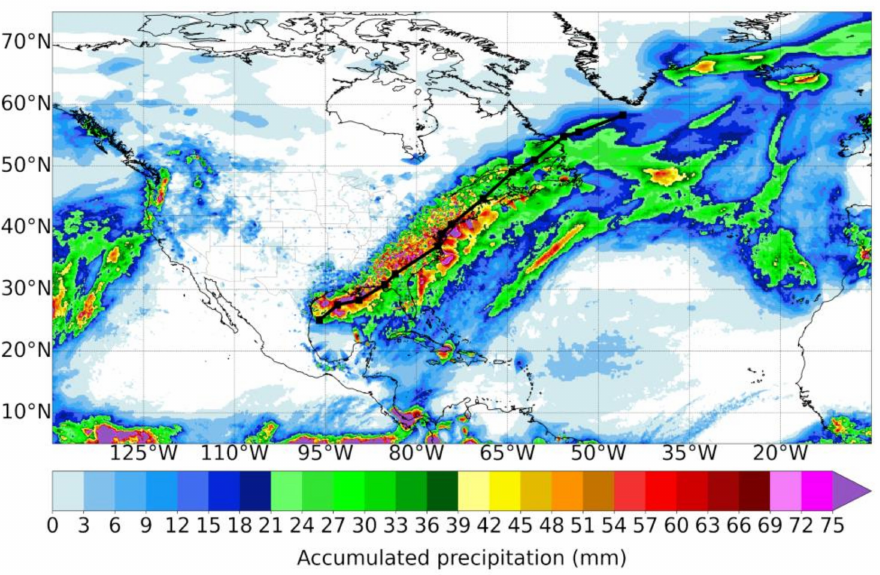
Figure 4. Accumulated precipitation from the Multi-Source Weighted-Ensemble Precipitation dataset from 12 March 1993 at 1200 UTC to 15 March 1993 at 1800 UTC. The black line represents the SC93 trajectory, while the centre of SC93 every 6 h is marked with a filled